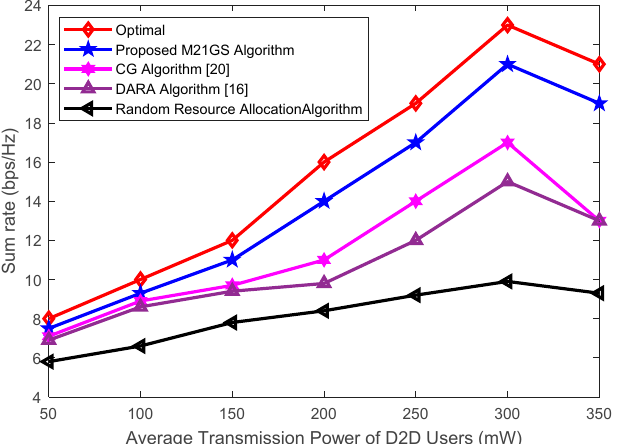
Figure 10. Comparison of the sum rate of the algorithms under the average transmission power of D2D users.